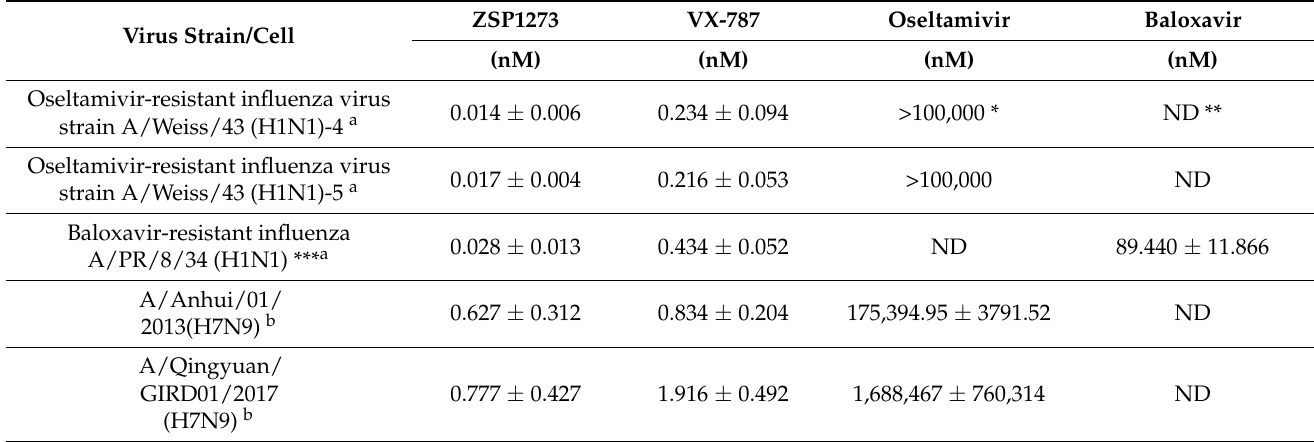
Table 2. Inhibitory activity of ZSP1273 against drug-resistant strains and highly pathogenic avian influenza